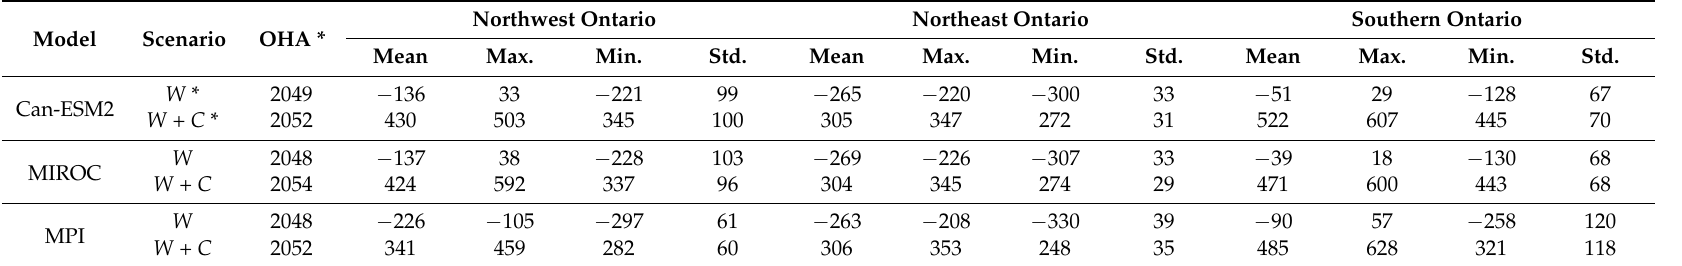
Table 2. Net Present Values (NPV, $ · ha − 1 ) of timber and carbon by region for the baseline